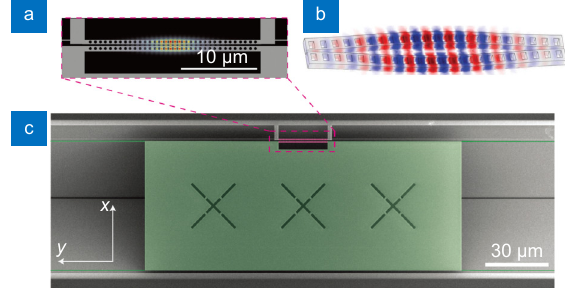
Fig. 27 | ( a ) Zoom-in of the zipper nanocavity region. ( b ) Schematic of the distorted zipper cavity showing the magnitude of the electric field. ( c ) False-coloured SEM image of the typical optomechanical accelerometer. Figure reproduced with permission from ref. 150 , Springer Nature.